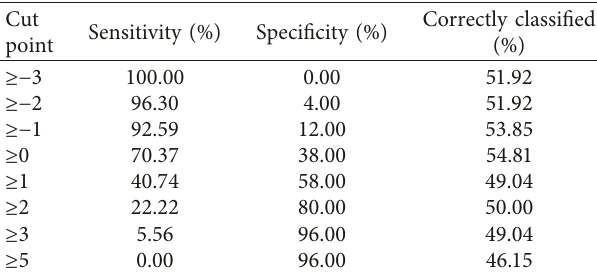
Table 6: Diagnostic accuracy and cut-offs for central corneal thickness.